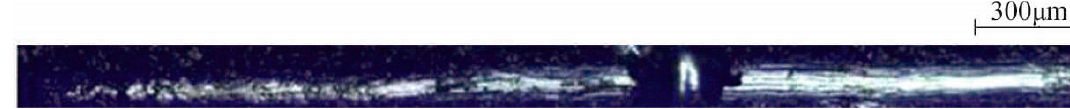
Figure 8. Test results of adhesion of the DLC coating to the Ti-13Nb-13Zr alloy—polished.